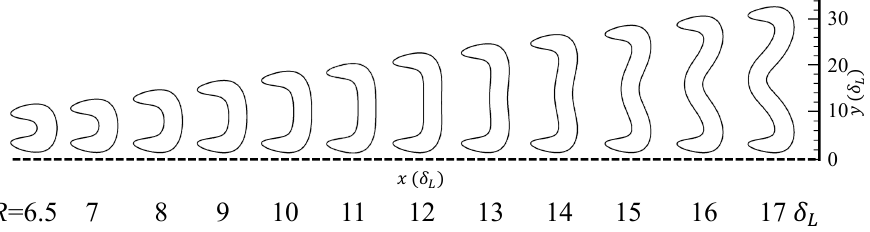
Figure 4. Response of the reaction zone shape to the change in channel width for the critical condition in small channels. Solid lines are the isolines of the reaction rate w + = 0.01, θ = 4. As the channel width is further increased beyond R = 14 δ L , a cusp appears at the flame surface near the centerline, while the reaction zone near the wall becomes convex. The